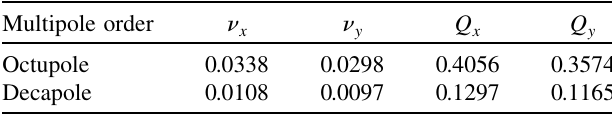
TABLE V. Variation of cell ( (cid:4) different orders of polynomial fit to the ideal field profile.